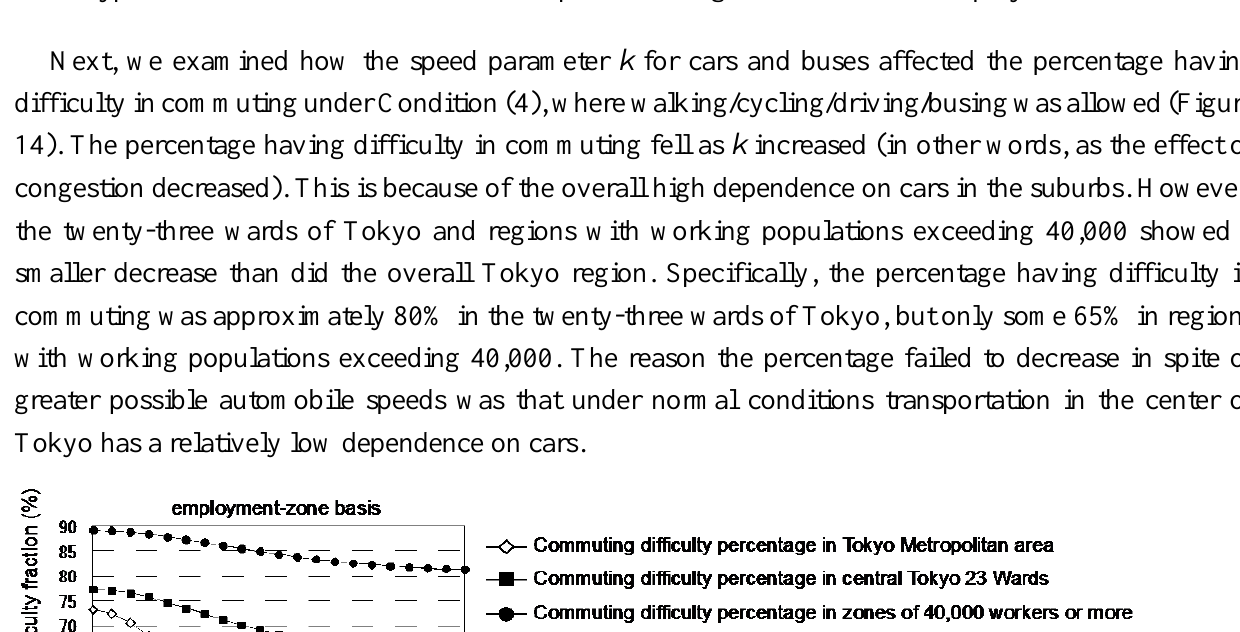
Figure 13. Spatial distribution of percentages of commuting difficulty as impacted by four hypothetical conditions of available transport according to residential and employment zones.